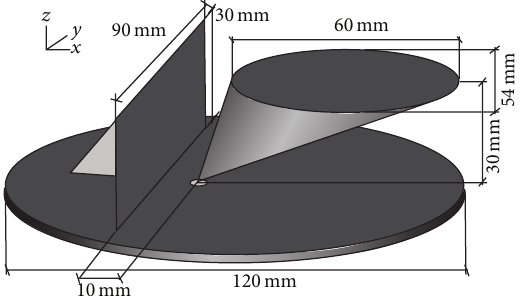
Figure 10: Conical antenna with elliptical aperture and reflector.